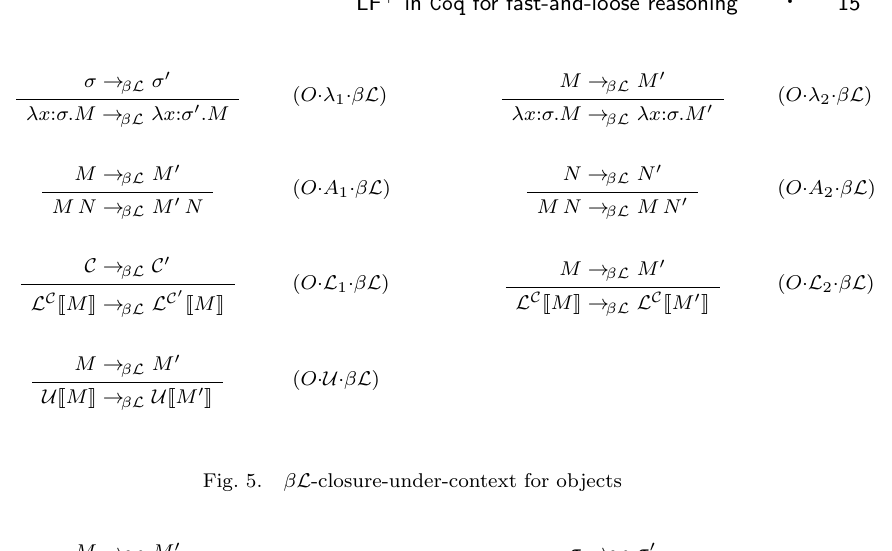
Fig. 6. β L -closure-under-context for lock conditions